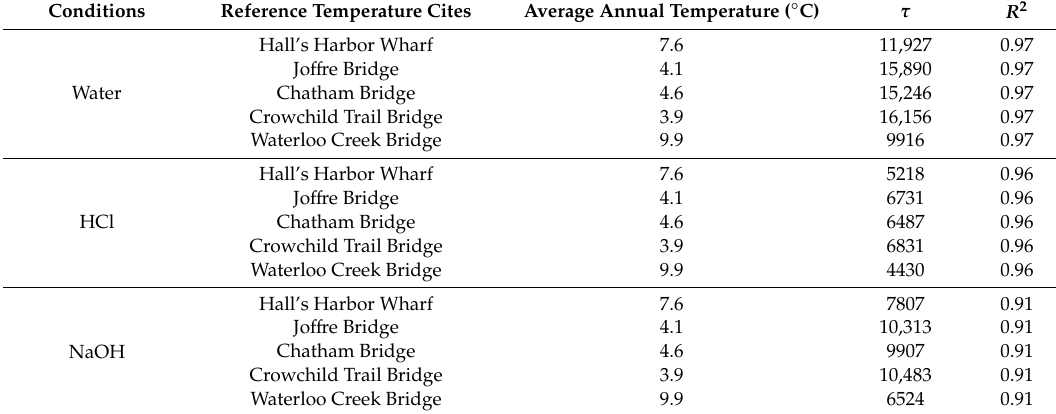
Figure 10. Master curves of CFRP composite exposed to different annual temperatures ( a ) Water, ( b ) HCl and ( c ) NaOH solution. Table 8. Coefficient of regression equations for the master curves of CFRP composites under various immersion conditions.